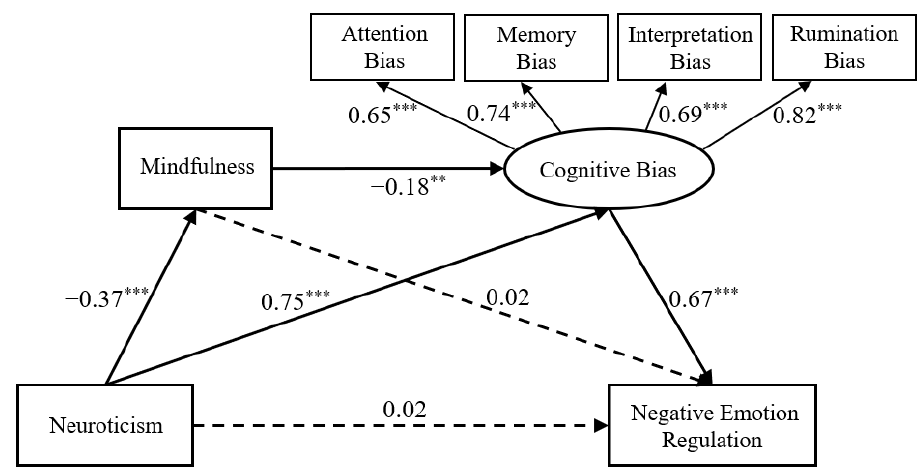
Figure 2. Path coefficient of the chain mediation model. Note. ** p < 0.01, *** p < 0.001. The significance of mediation effects was tested using the Bias-Corrected Bootstrap